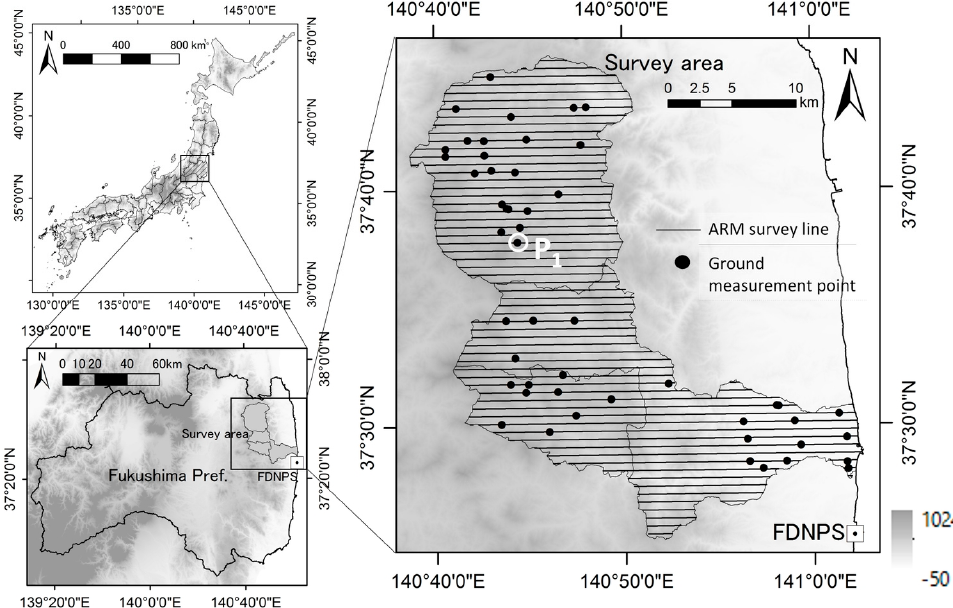
Figure 1. Scheme of survey area and measurement points. Black dots indicate ground measurement points. Straight lines indicate survey lines of airborne radiation survey (ARM). P 1 indicates the ground measurement point with the highest elevation.